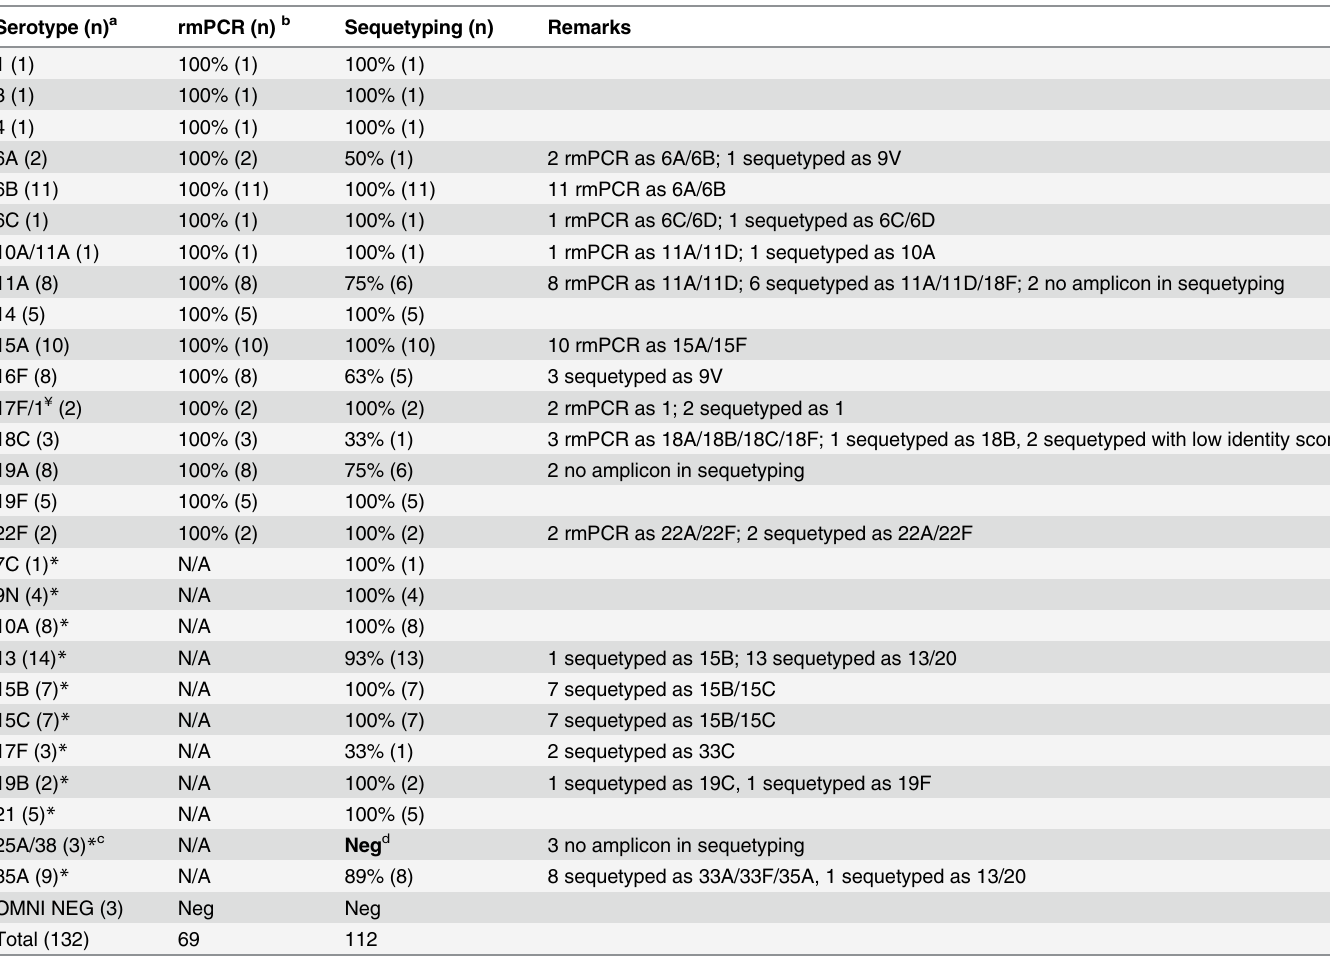
Table 2. Carriage isolate serotyping method